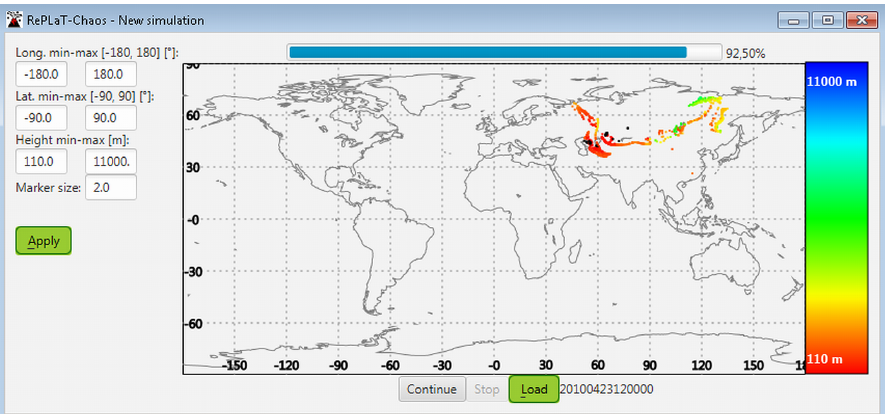
Figure A3. Example for tracking the calculation of the simulation with displaying the particle positions. The simulation and the pollutant cloud are initialized with the parameters in Figure A1. The colorbar indicates the altitude of the